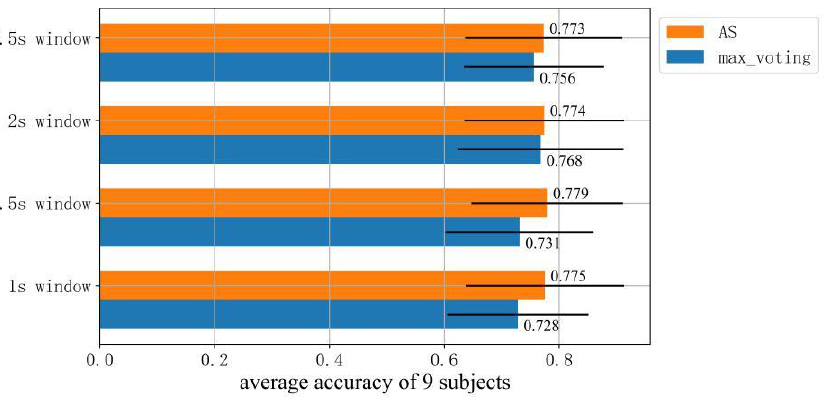
Figure 13. Comparison of classification accuracies of the proposed AS algorithm with the Max Voting algorithm in the case of eleven windows.